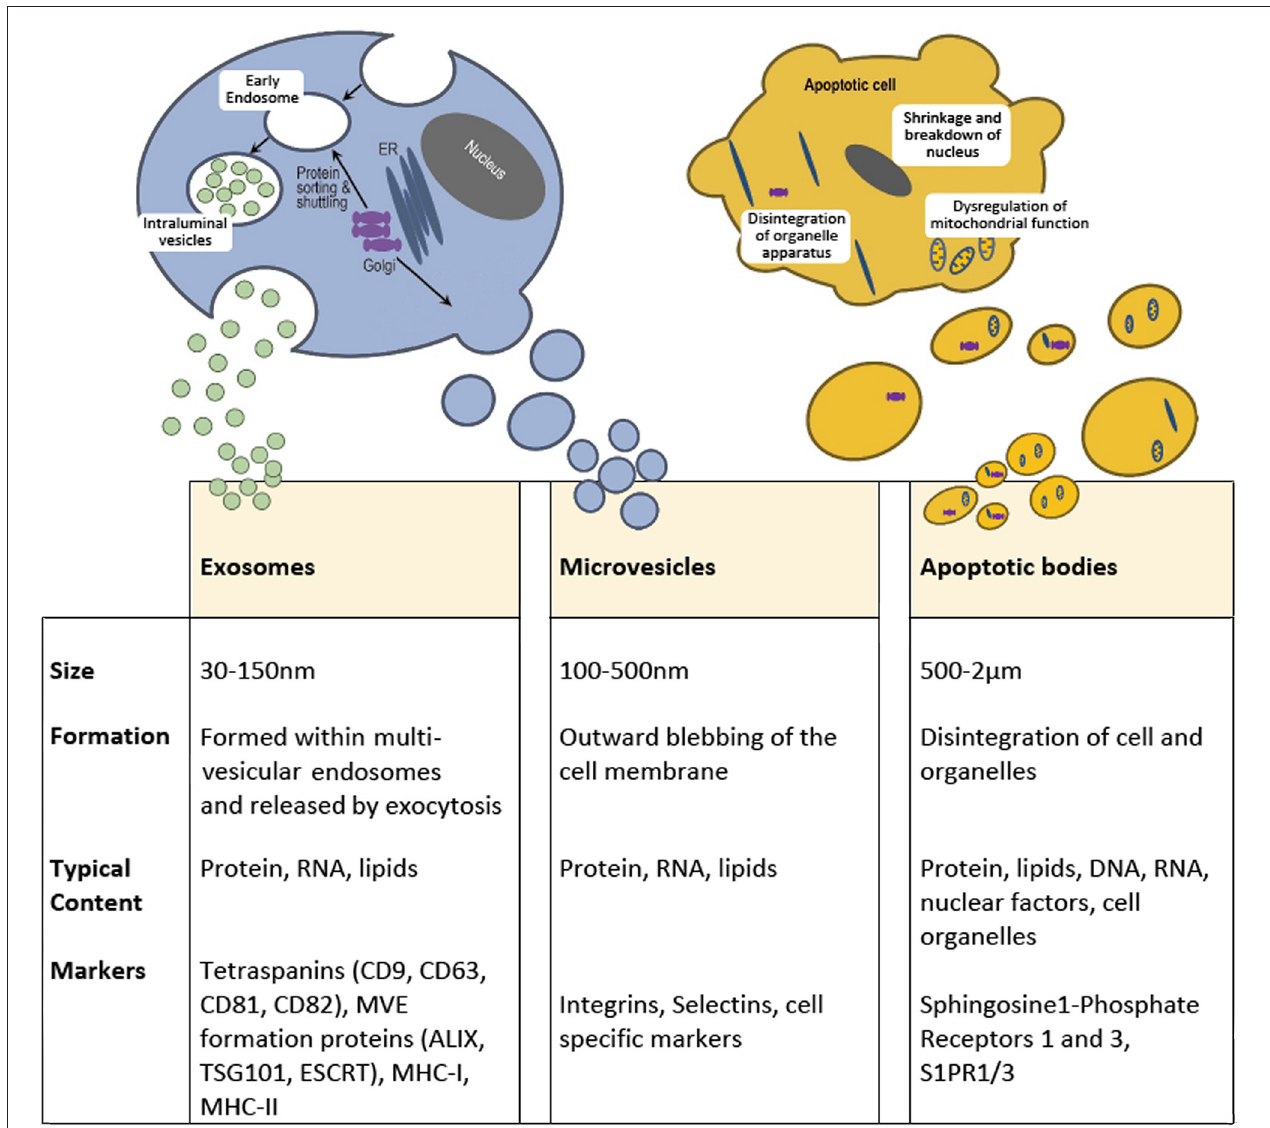
FIGURE 1 | Extracellular vesicles are broadly divided into three subtypes based on size, formation, and content. Exosomes range from 30 to 150 mn and originate within multivesicular endosomes and carry protein, RNA and lipids. Microvesicles or Ectosomes, are often but not always larger and form through an outward budding of the plasma membrane and also contain protein, RNA and lipids. Microvesicles express surface markers specific to the membranous elements of the cell of origin, including integrins and selectins. Apoptotic bodies are highly diverse and can be a few microns in diameter but are a property of dying cells and therefore contain cell debris, organelles, nuclear factors, alongside protein, mRNA and lipids. The molecular composition of these classes of extracellular vesicle are